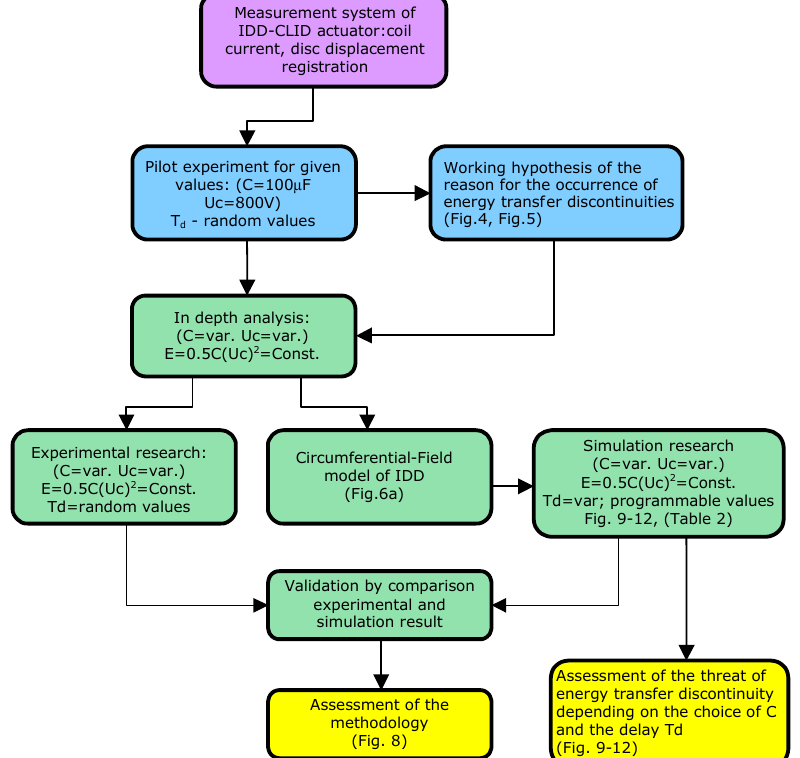
Figure 2. Flow-chart of the performed investigation.